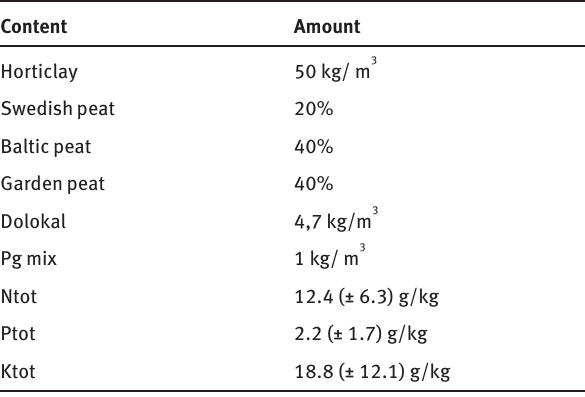
Table 1: Content of organic soil used as Earth control (Lentsepot- grond, Horticoop) and the total Nitrogen (Ntot), Phosphorous